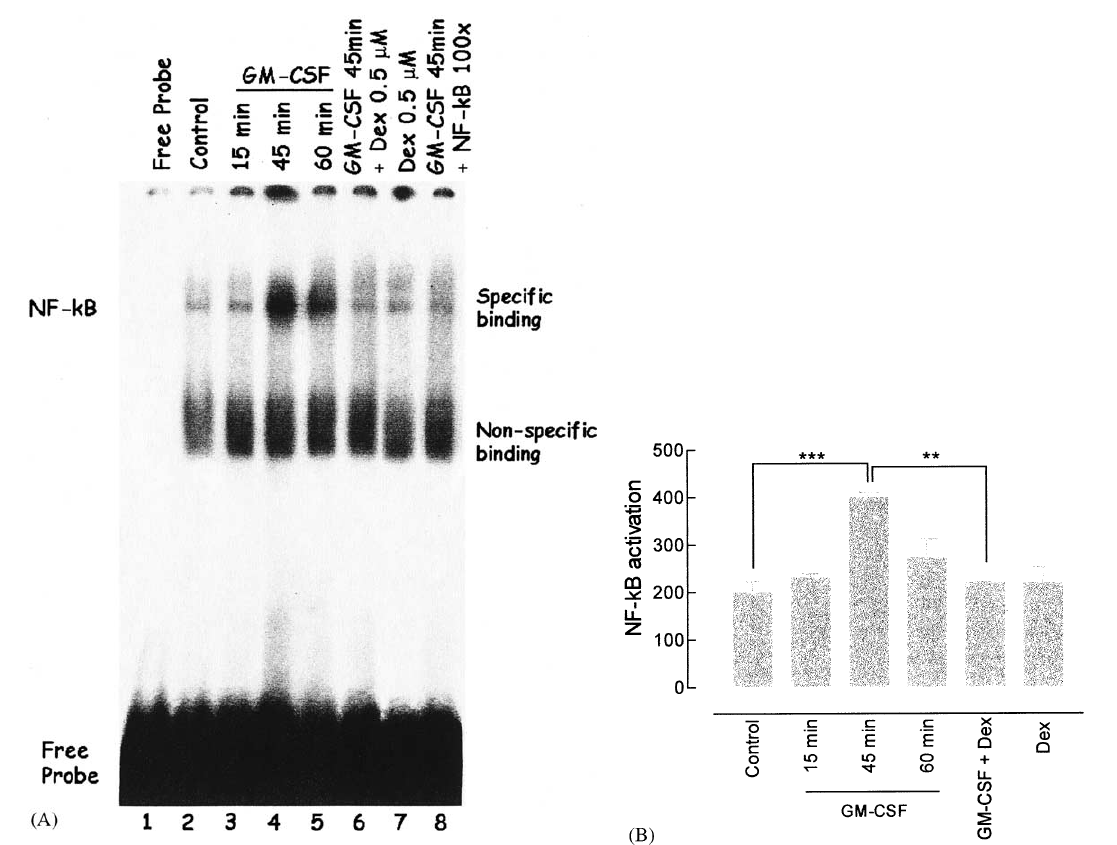
FIG. 3. Effect of dexamethasone (Dex) on GM-CSF-induced NF- k B binding to DNA in FSDC. FSDC (2 (cid:3) / 10 6 cells) were incubated in culture medium alone (control, lane 2) or in the presence of 100 ng/ml of GM-CSF, for 15, 45 and 60 min (lanes 3 (cid:1) / 5). In lane 6 the cells were pre-incubated with 0.5 m M dexamethasone for 30 min before stimulation with GM-CSF and dexamethasone for 45 min. Control experiments, where the cells were incubated with dexamethasone for 75 min, are shown in lane 7. Unlabeled oligonucleotide (i.e. non-radioactive NF- k B consensus containing oligonucleotide) was used in excess (100-fold) to demonstrate specificity of the induced bands (lane 8). (A) Nuclear extracts were subjected to EMSA analysis as described in Materials and methods. The blot shown is representative of three blots yielding similar results. (B) The bands were quantified with an image analyzer and the results are shown as means 9 / standard error of the mean from three independent experiments. **p B / 0.01 and ***p B / 0.001, as determined by one-way analysis of variance with Bonferroni’s multiple comparison